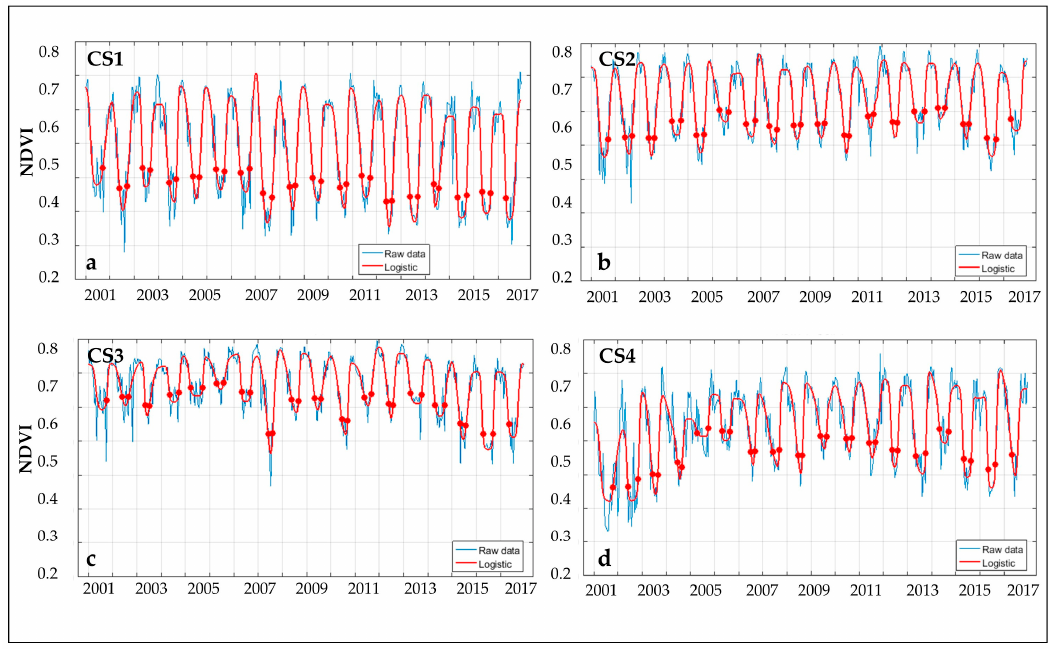
Figure 7. Original NDVI data from Terra-MODIS (in blue) and the fitted functions obtained by the double logistic filter curve fitting (CF) method in TIMESAT (in red) at ( a ) CS1, ( b ) CS2, ( c ) CS3 and ( d ) CS4.